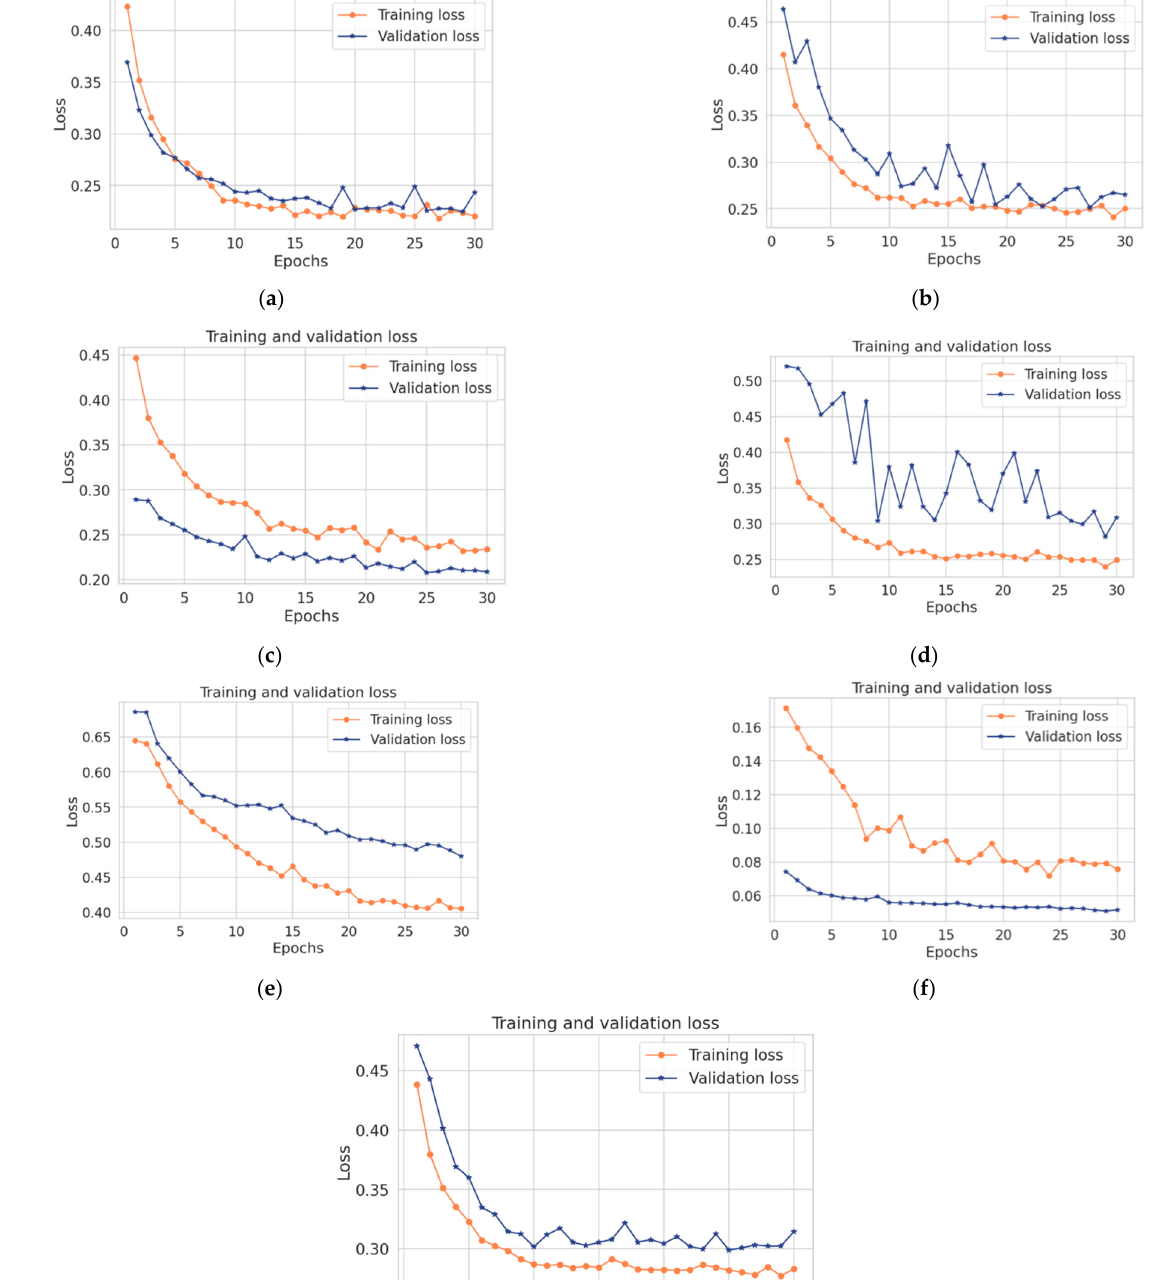
Figure 9. Loss rate for the various physiological sensors. ( a ) HR sensor. ( b ) ABPSys sensor. ( c ) ABPMean sensor. ( d ) pulse sensor. ( e ) RESP sensor. ( f ) SpO2 sensor. ( g ) ABPDias sensor.